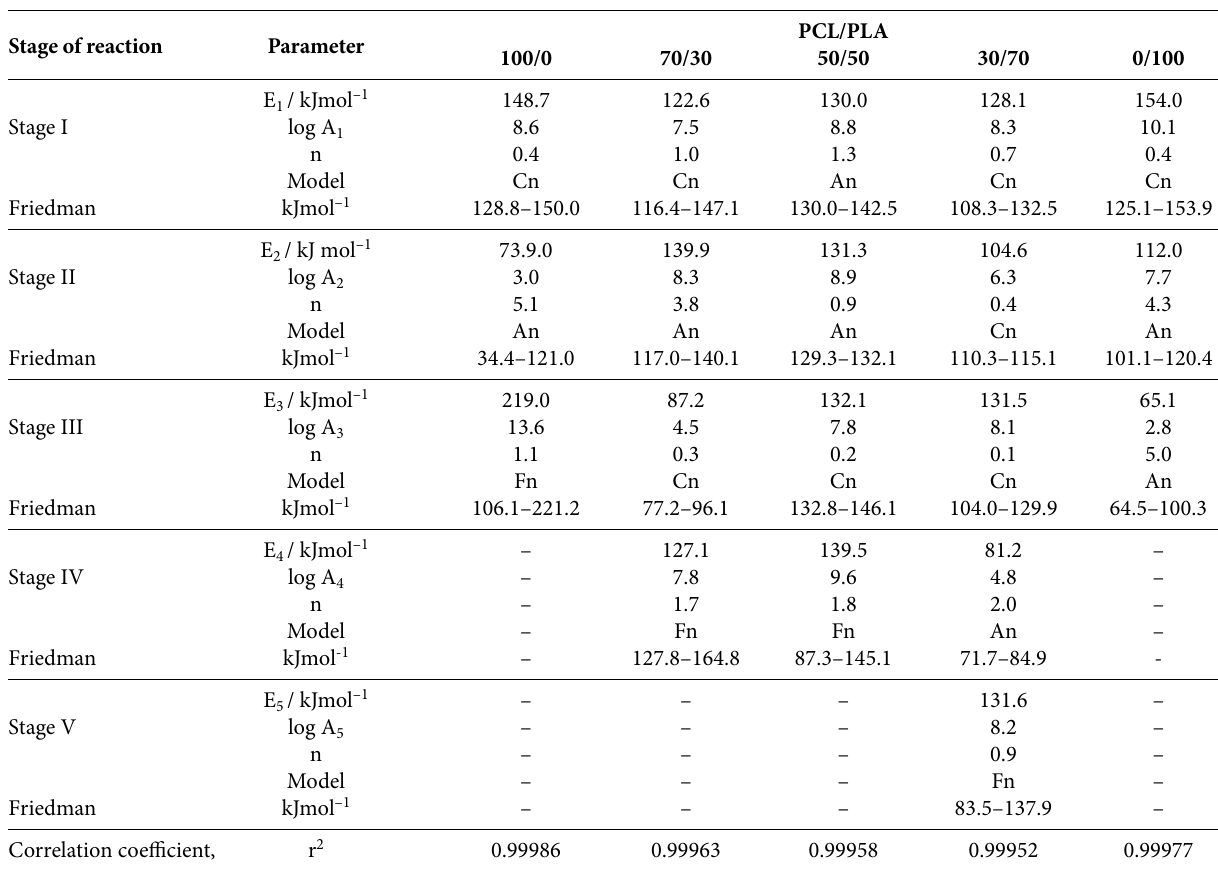
Table 4. The most probable kinetic models of thermal degradation of PCL/PLA blends according to F-test and correlation coefficient obtained by using multivariate non-linear regression analysis Stage of